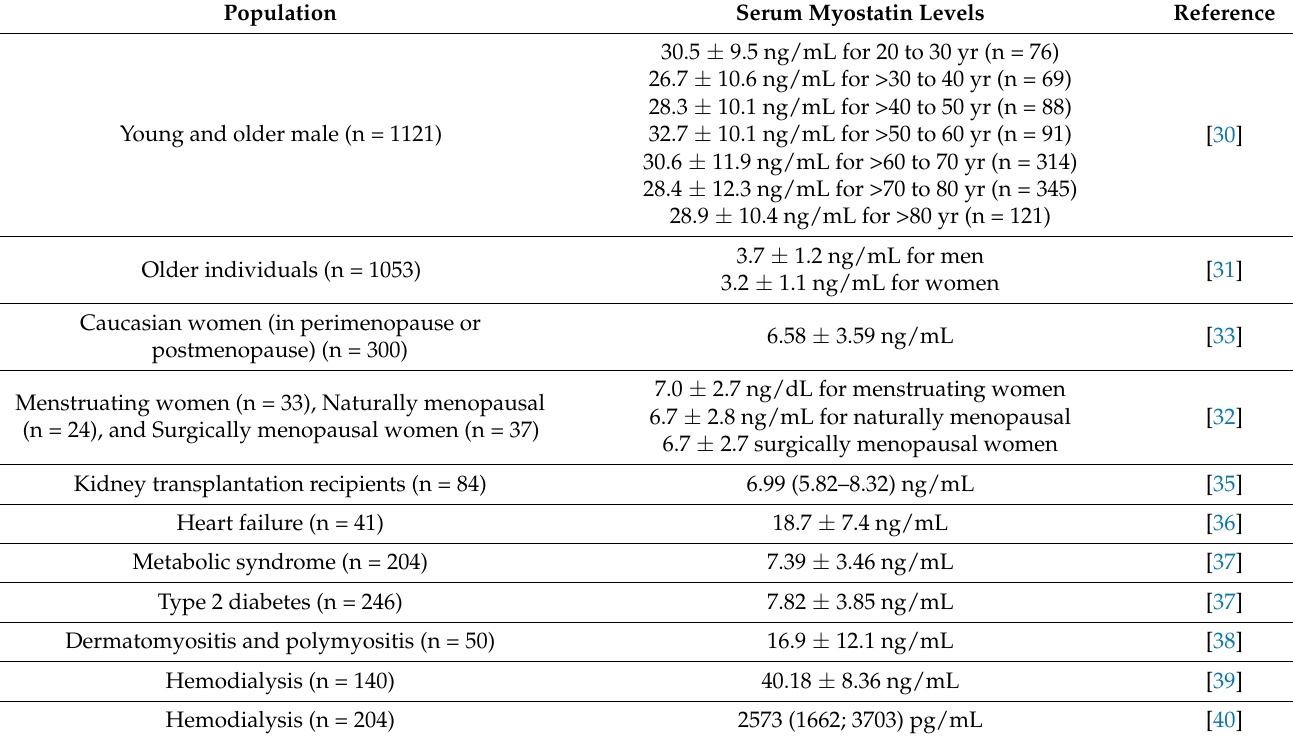
Table 1. Serum myostatin levels in different